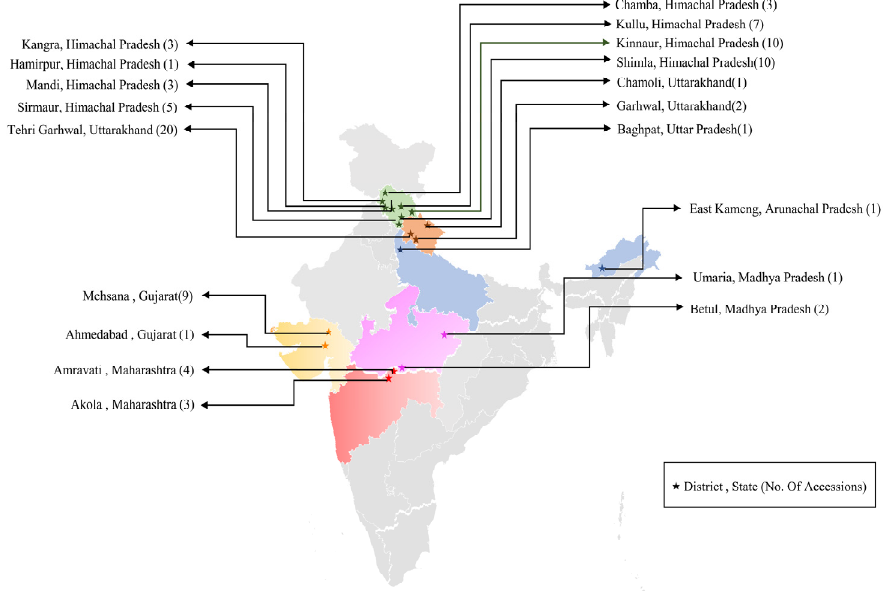
Figure 1. Distribution of grain amaranth accessions across India.